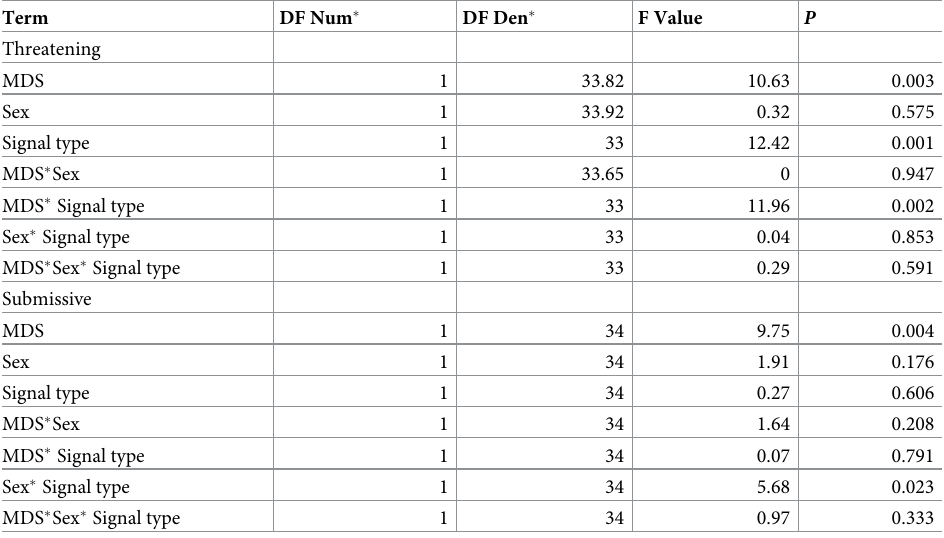
Table 6. Effect of sender’s social rank (modified dominance David’s scores–MDS), sex, and signal type (unimodal or multimodal) on the occurrences of engagement responses to threatening and submissive behaviors by white- lipped peccaries (N =